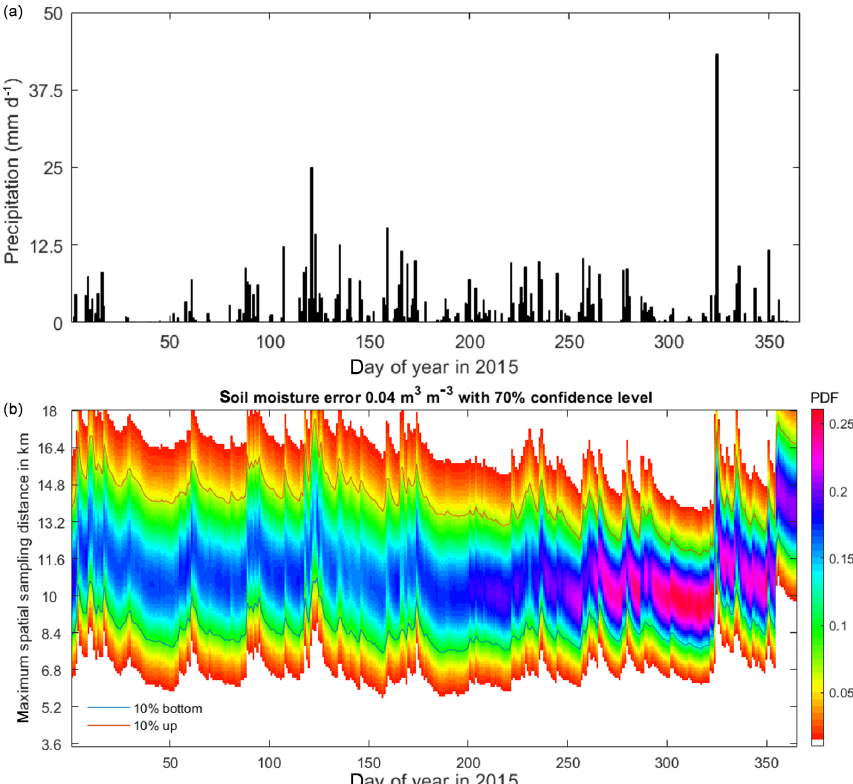
Figure 4. Precipitation in VR01 (a) and time series of the distribution of the maximum allowed soil moisture sampling distance for each SMOS or SMAP pixel to assure a sampling error below 0.04cm 3 cm − 3 (70% confidence) for the year 2015 (b) . The colored intensity is proportional to the probability of occurrence. The 10th and 90th percentiles are indicated as blue and read lines, respectively. Every precipitation event makes the soil moisture field more homogenous regarding high PDF and larger maximum spatial sampling distance, which means fewer stations are